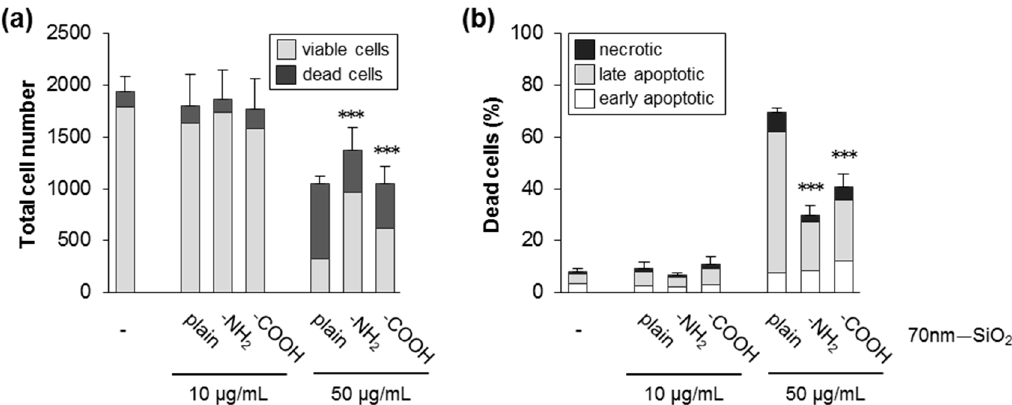
Figure 4. Surface modifications reduces cytotoxicity of silica NPs. HCT116 wt cells were exposed to SiO 2 —NPs (70 nm) with a plain, NH 2 —, or COOH—modified surface in the absence of FBS. After 24 h, the cells were processed and analyzed as described in Figure 2. ( a ) The total cell number divided into living and dead cells. ( b ) The percentage of dead cells relative to the total cell number divided into the di ff erent classes of cell death as indicated. Data show mean values of two independent experiments carried out with four replicates ( n = 8). The error bars are SD values related to the total cell number ( a ) or the percentage of total dead cells ( b ), respectively. *** p < 0.001 indicates significant di ff erences in the number of viable cells ( a ) and total dead cells ( b ) after administration of modified NPs compared to corresponding concentrations of plain particles.